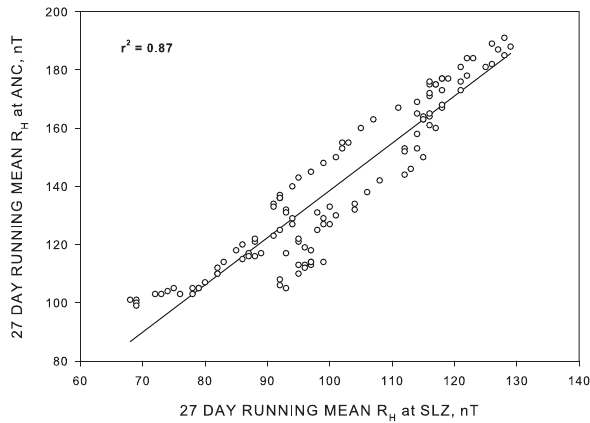
Fig. 1b. Mass plot of the 27-day running mean values of the daily range in H at ANC plotted against values at SLZ.